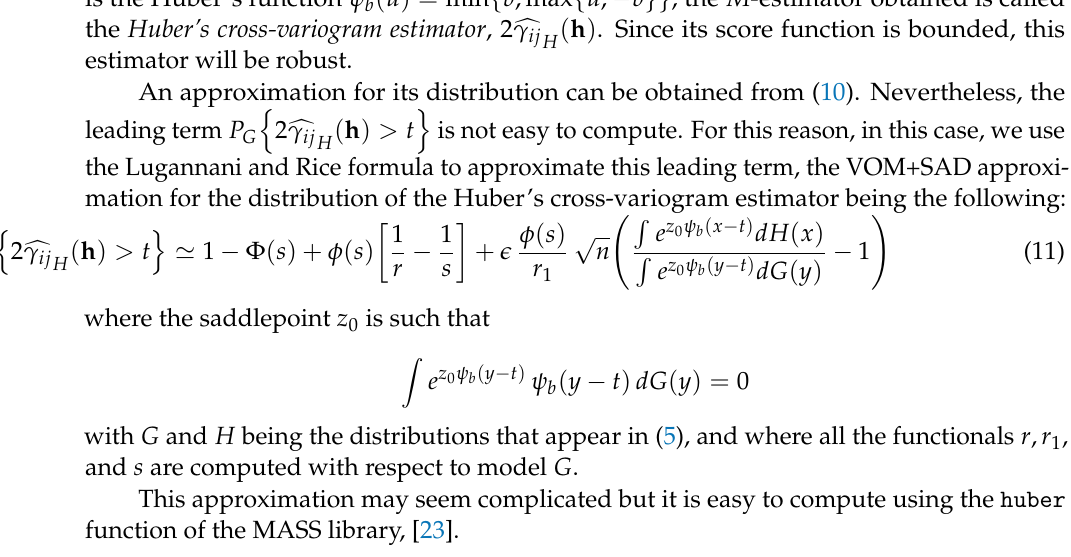
( h ) (bottom row of figures), α